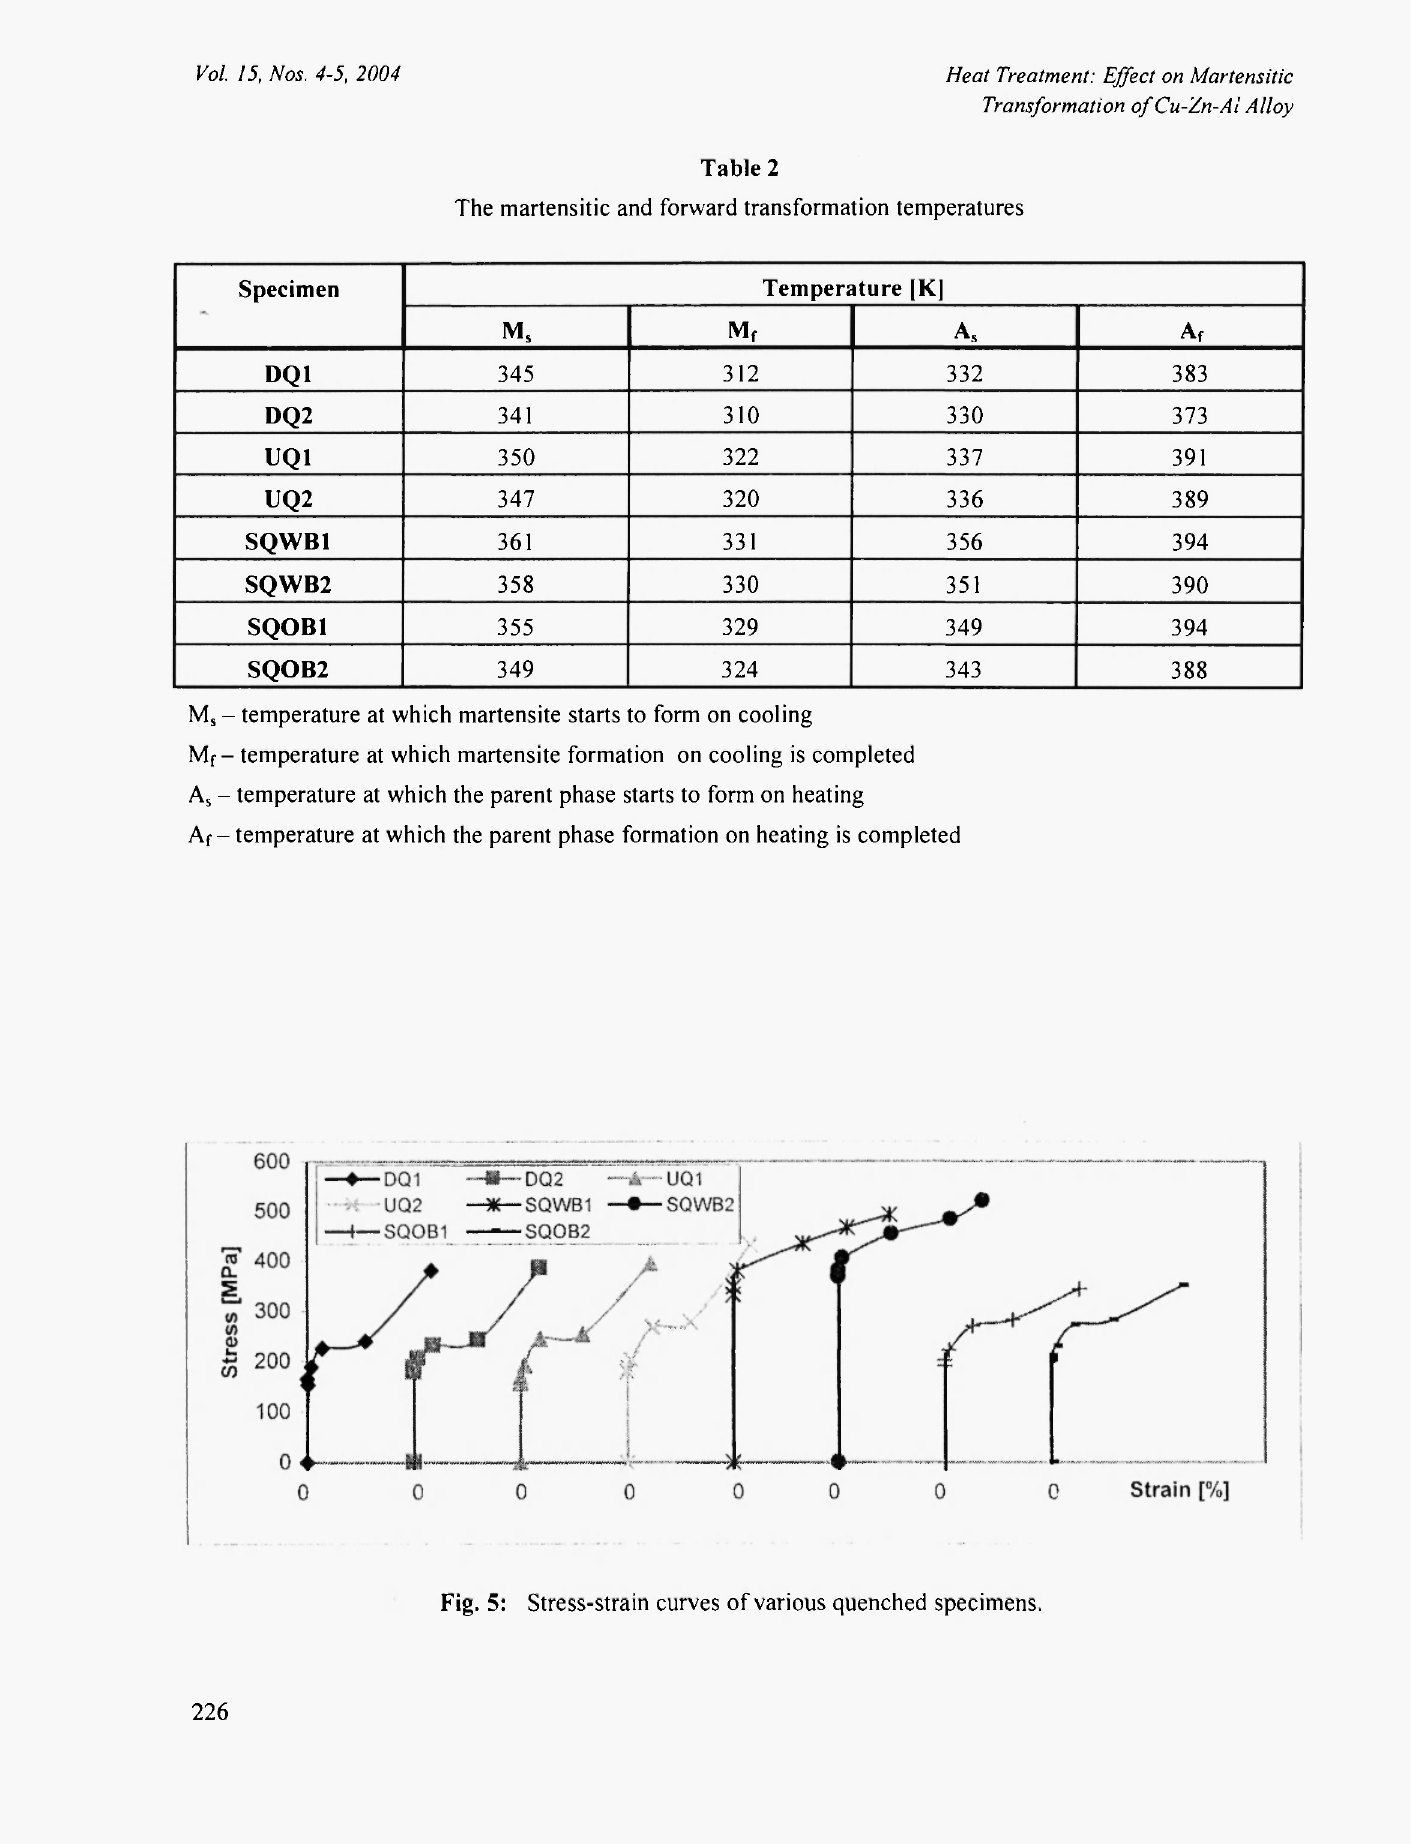
Fig. 5: Stress-strain curves of various quenched